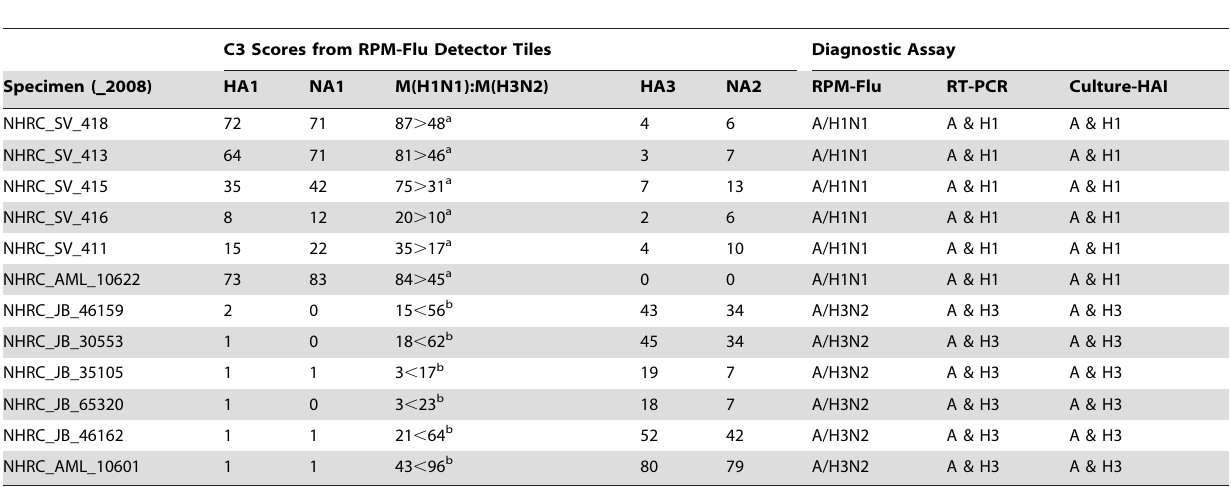
Table 5. Concordance of RPM-Flu determination of A/H1N1 and A/H3N2 subtypes with benchmark RT-PCR HA1/HA3 subtyping panel and cell culture-HAI HA1/HA3 subtyping